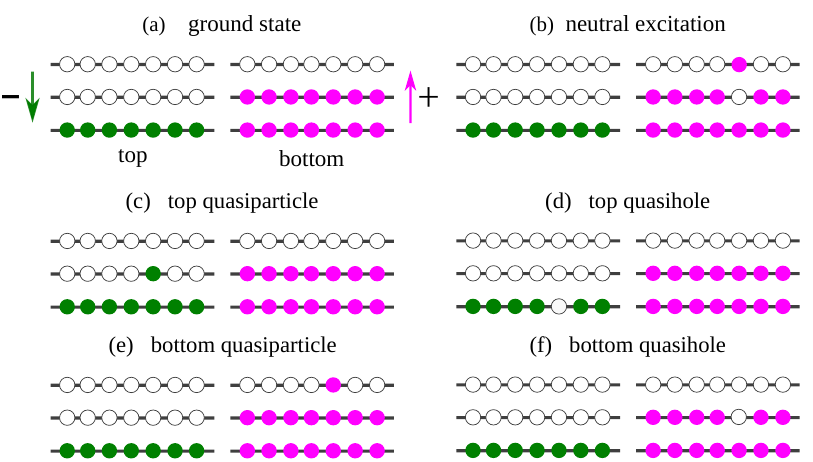
Figure 2: Schematics of the composite fermion configurations of the Ψ 221 state and elementary excitations. The electrons in the top and bottom monolayers are converted to their respective composite fermions. One species experiences negative effective magnetic field and the other experiences positive effective magnetic